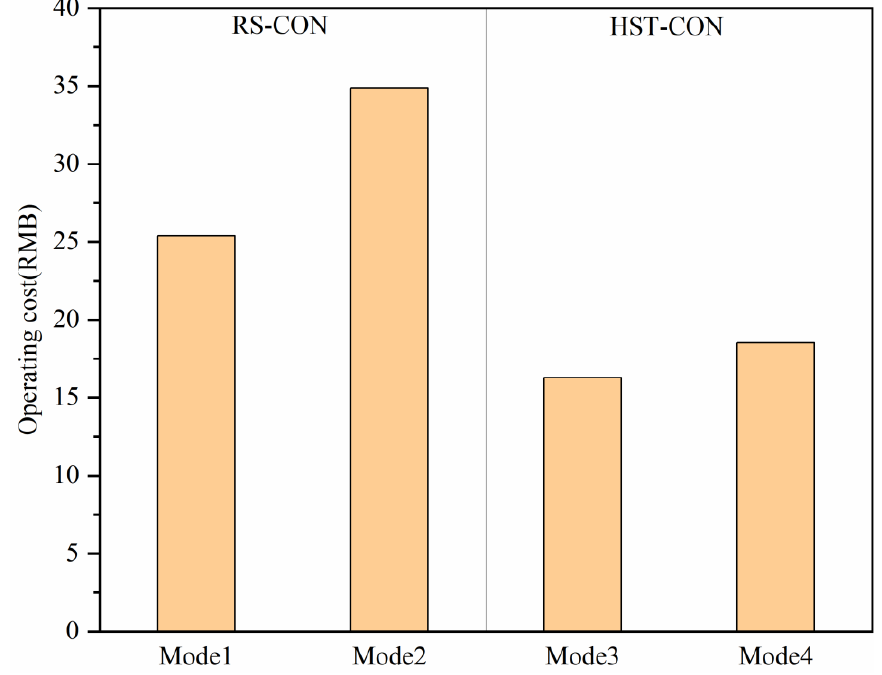
Figure 9. Operating costs under different control strategies.